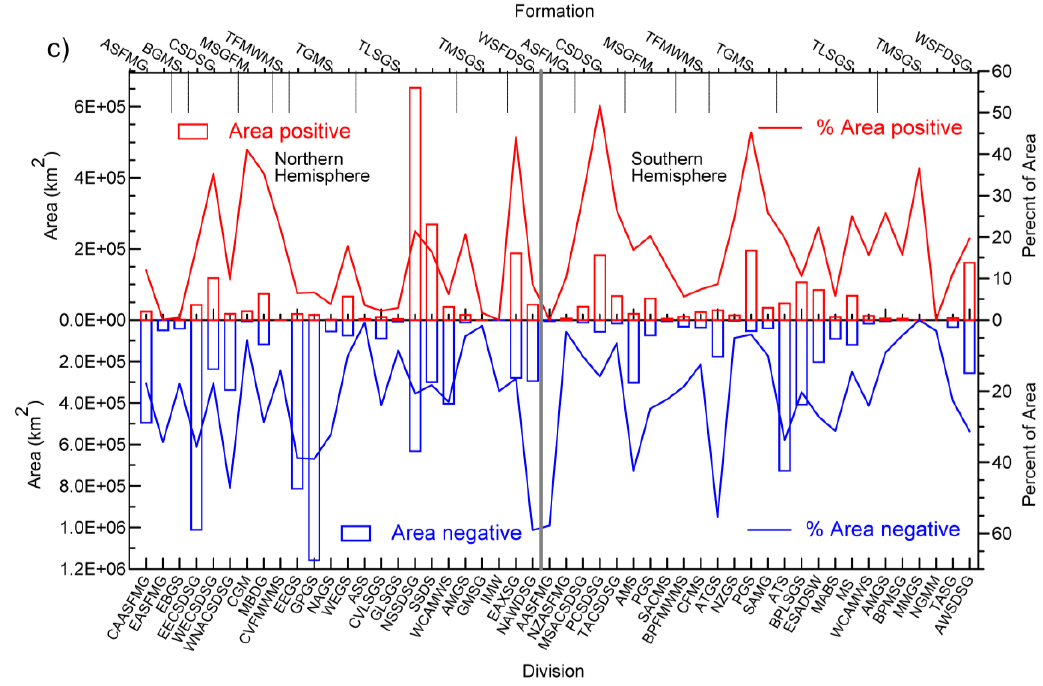
Figure 9. Area (km 2 ) and percentage of area of WGT Divisions exhibiting significant positive or negative trends in ( a ) F PV , ( b ) F NPV , and ( c ) F BS . Key to Formation and Division acronyms in Table A2.